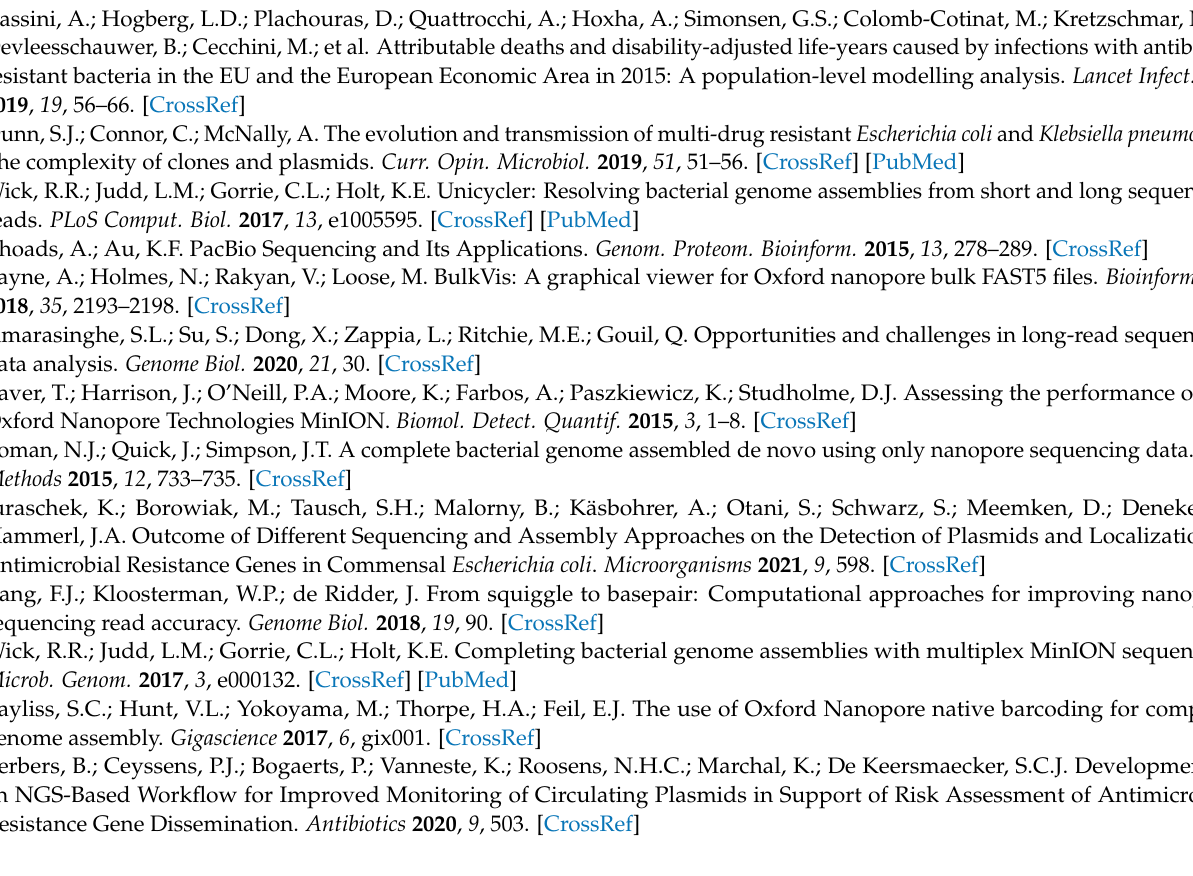
blers; Table S5_Summary of Prokka annotation results for top performing assemblers; Table S6_Full Prokka table for top performing assemblers; Table S7_Identified plasmids in assemblies produced by top performing assemblers; Table S8_Identified AMR genes in assemblies produced by top per- forming assemblers; Table S9_Identified VFs in assemblies produced by top performing assemblers; Table S10_Mixed cultured